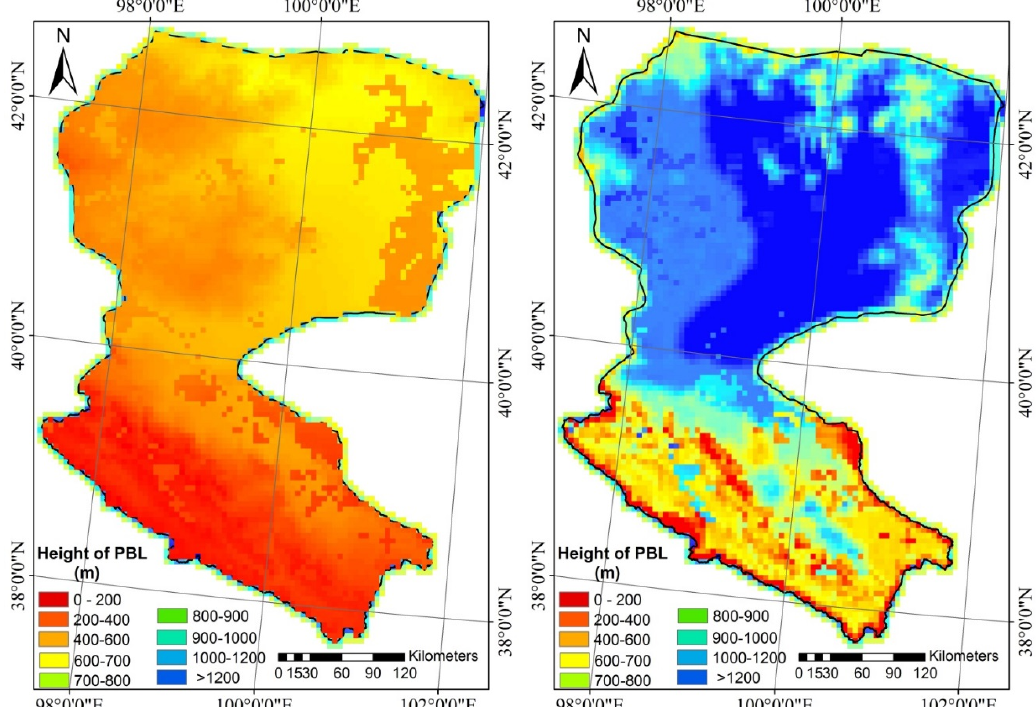
Figure 10. Spatial variation of the MH derived from the MODIS MOD07 product for the clear days 8 January and 6 July